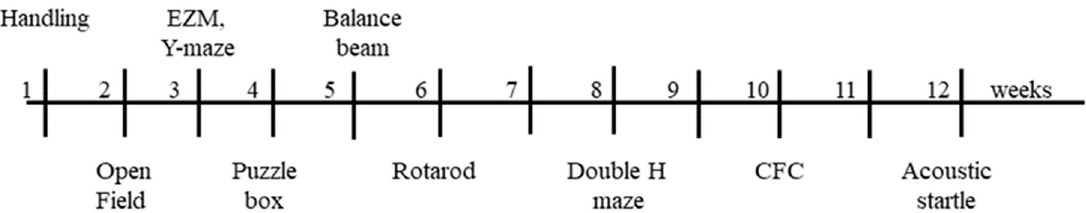
Figure 1. Timeline. Order and time frame of tasks. Numbers indicate the week each task was carried out. Weeks with no task, mice were allowed to rest to reduce stress. EZM, elevated zero maze. CFC, context fear conditioning.